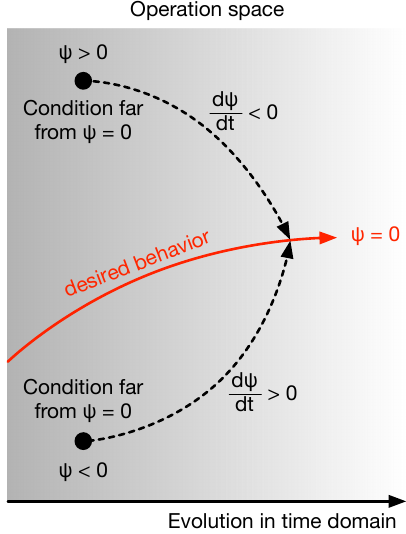
Figure 7. Derivation of the reachability